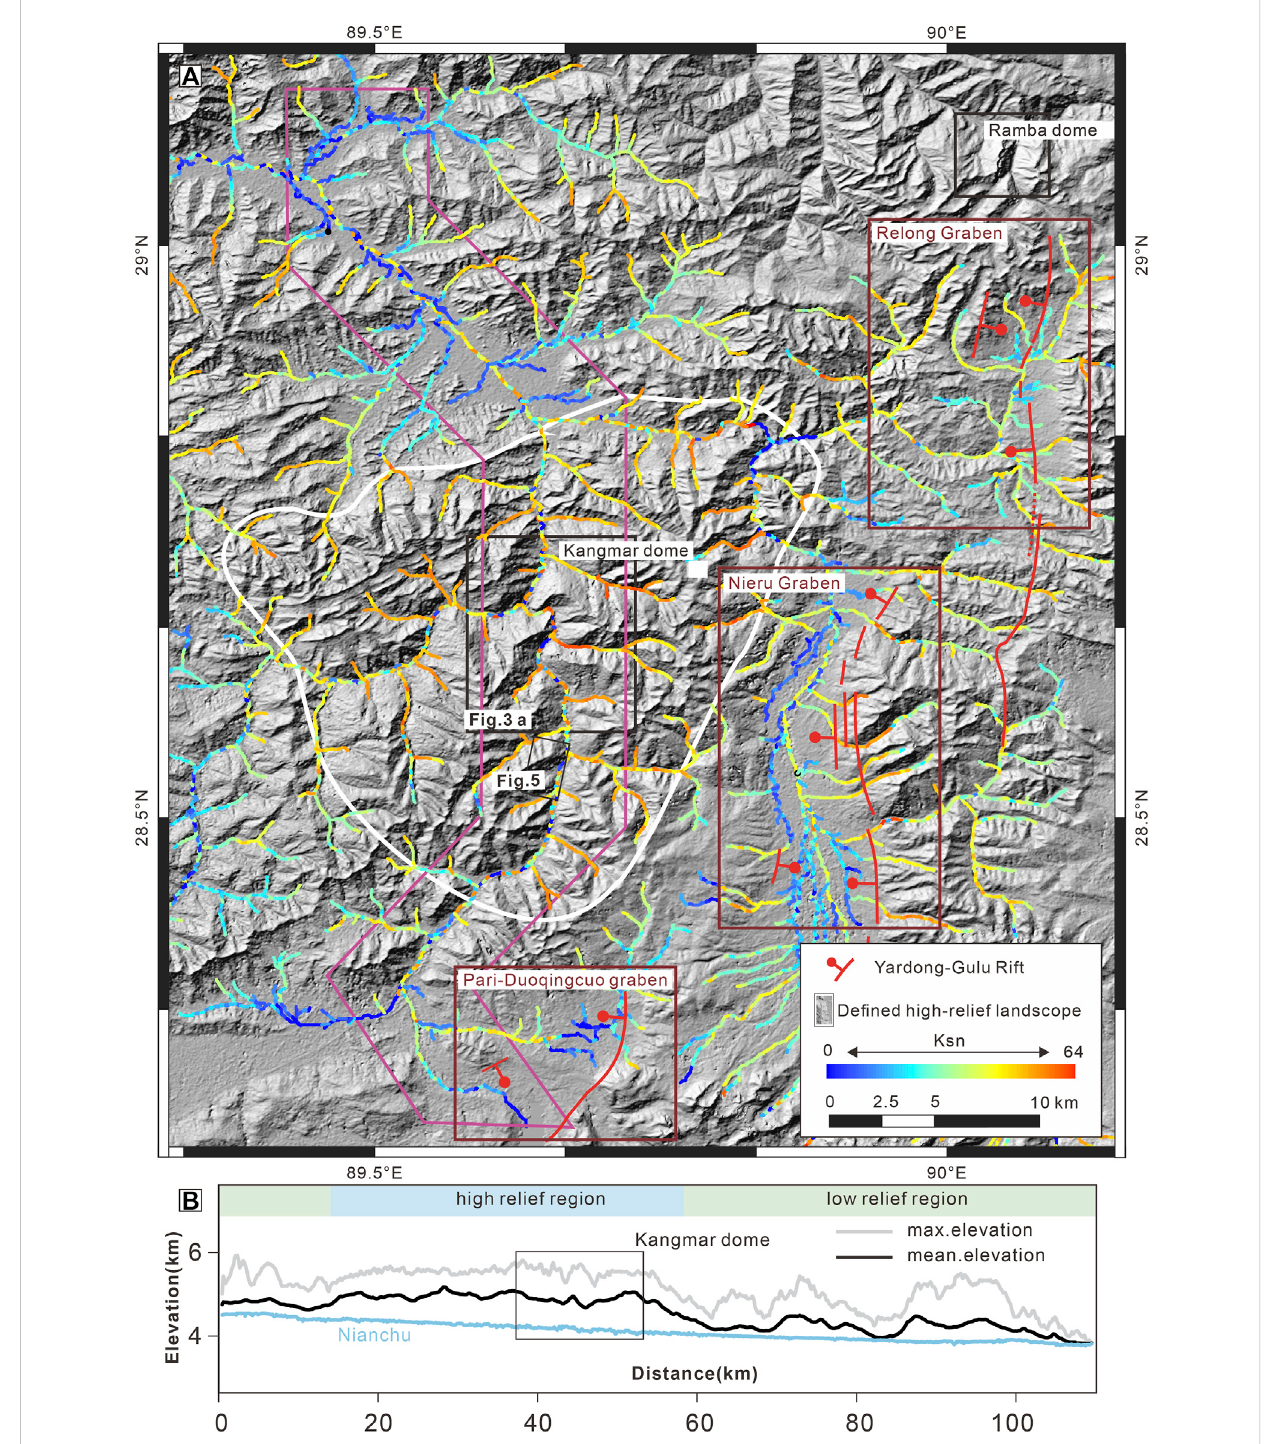
FIGURE 2 (A) RegionalchannelsteepnessinpartsoftheNianchucatchment.SeeFigure1forlocation.TwoblackboxesmarkthelocationsoftheKangmarand Rambadomes.ThedarkredframesmarktheregionalsegmentsoftheYadong-Gulurift. (B) Swathpro fi le[correspondingtothepurplerectangularboxin (A) ] along the Nianchu River, showing the undulating topography along the Nianchu